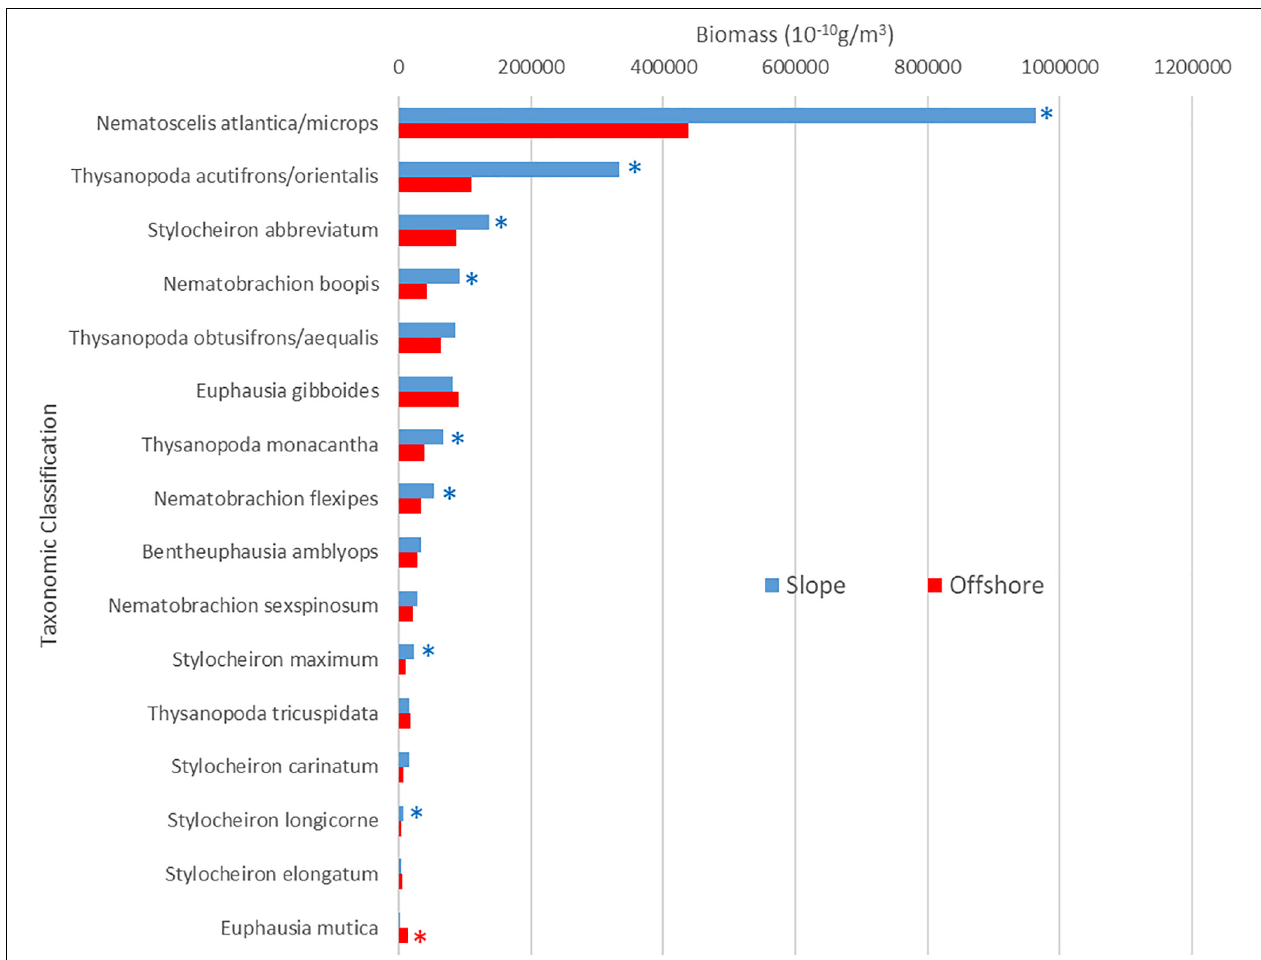
FIGURE 6 | Slope and offshore population biomass for abundant euphausiids. Asterisks indicate significantly greater biomass for slope (blue) or offshore (red) locations Species are arranged from maximum to minimum biomasses at slope